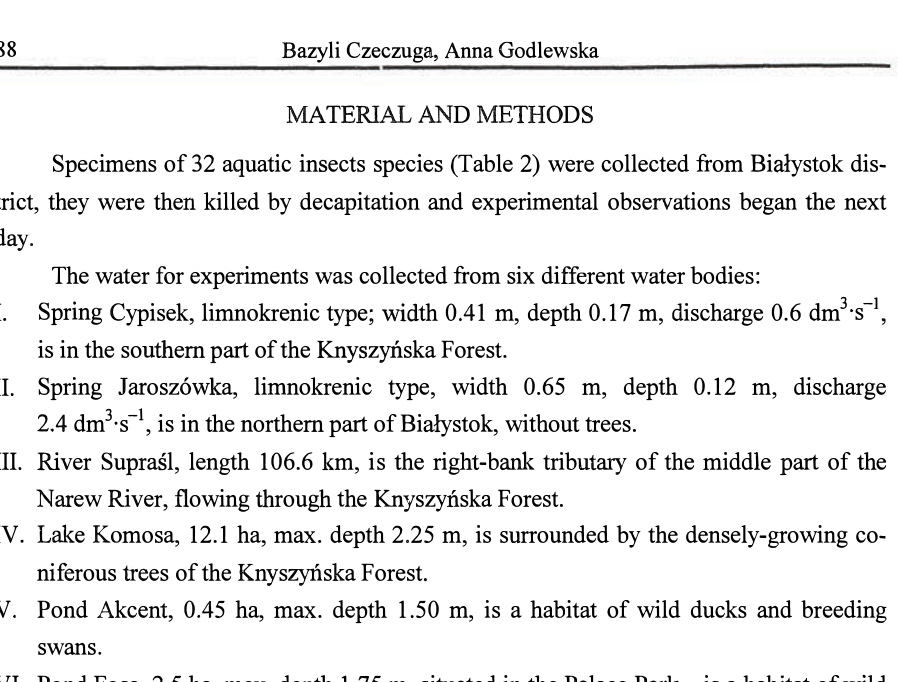
mg·dm-3 Chemical properties (in ) of water in particular water bodies (n =